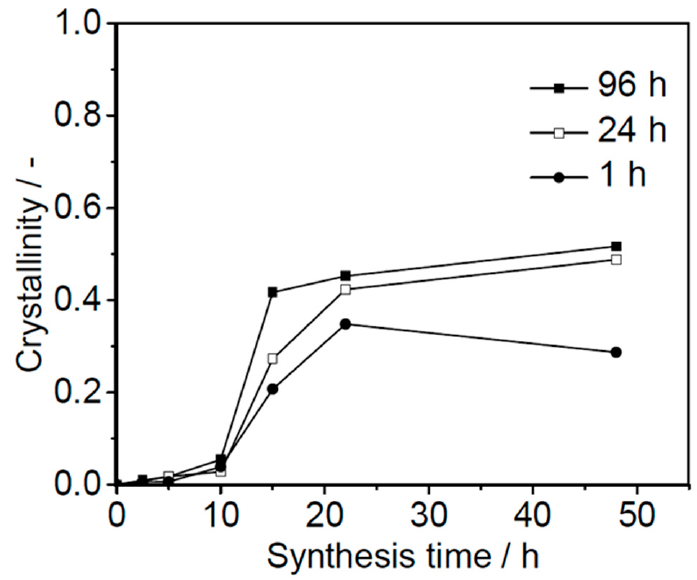
Figure 2. The effect of aging time on the rate of formation of MFI-type zeolites prepared in this work. The aging time shortens the synthesis time and slightly increases the yield of nanosized ZSM-5. The crystallinities were calculated by comparing the areas under the reflections in the XRD patterns of dried synthesis suspension to that of a washed product as described in the experimental part.